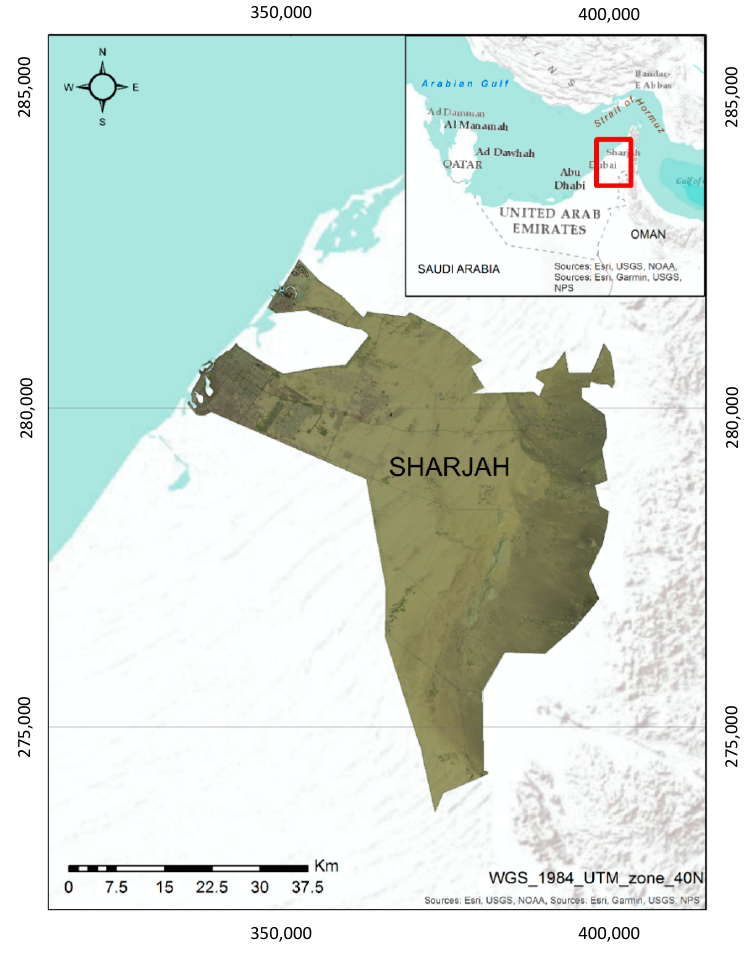
Figure 1. Study Area.